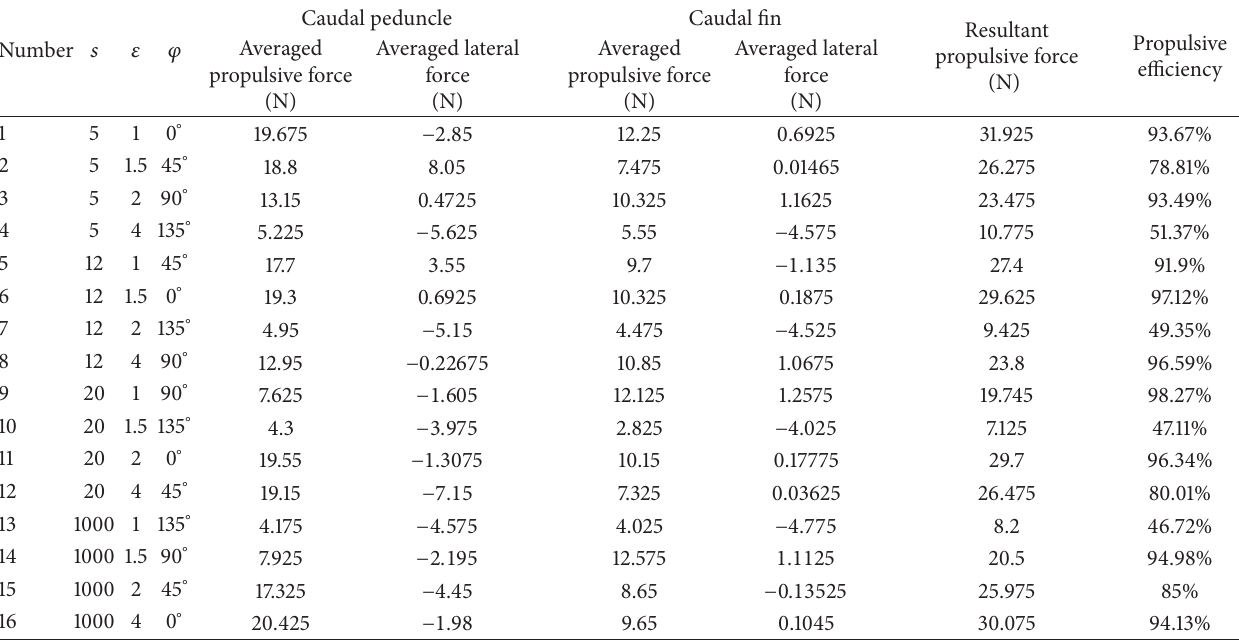
Table 2: Results of numerical computation.